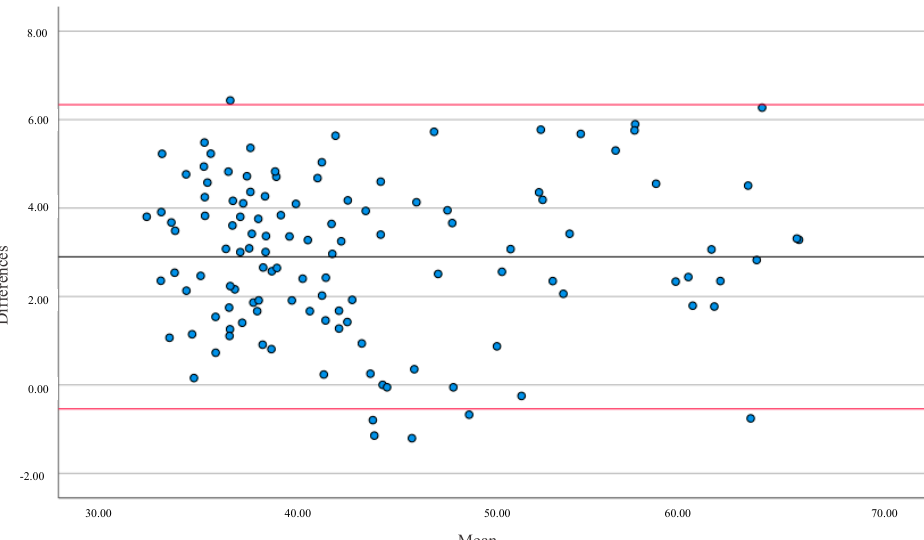
Figure 1. Bland-Altman analysis evaluated the differences in Fat-Free Mass (FFM) in kg between the two types of equipment (BIA and DXA). The solid line represents the Mean (2.90) and the red lines represent ± 1.96 SD for all populations. Upper limit = 6.34 SD; lower limit = − 0.54 SD.